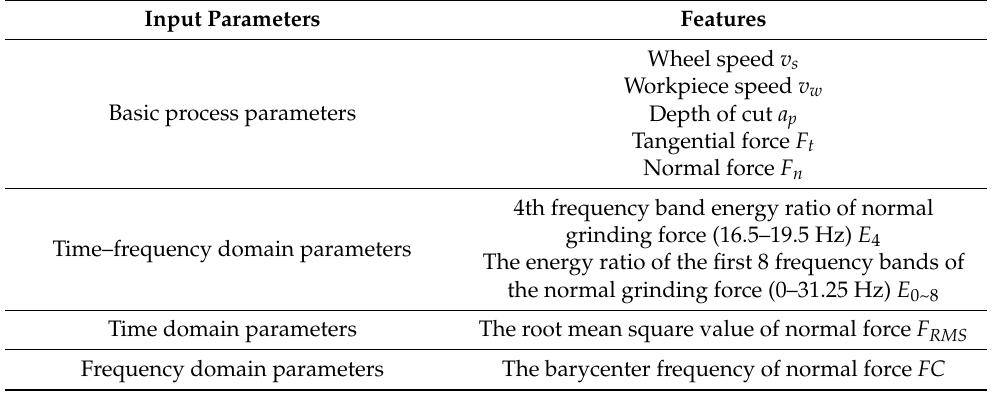
Figure 2. Processing of the normal force data: ( a ) time domain analysis of the normal force data; ( b ) frequency domain analysis of the normal force data; ( c ) time–frequency domain analysis of the normal force data. Table 3. Input parameters of the prediction